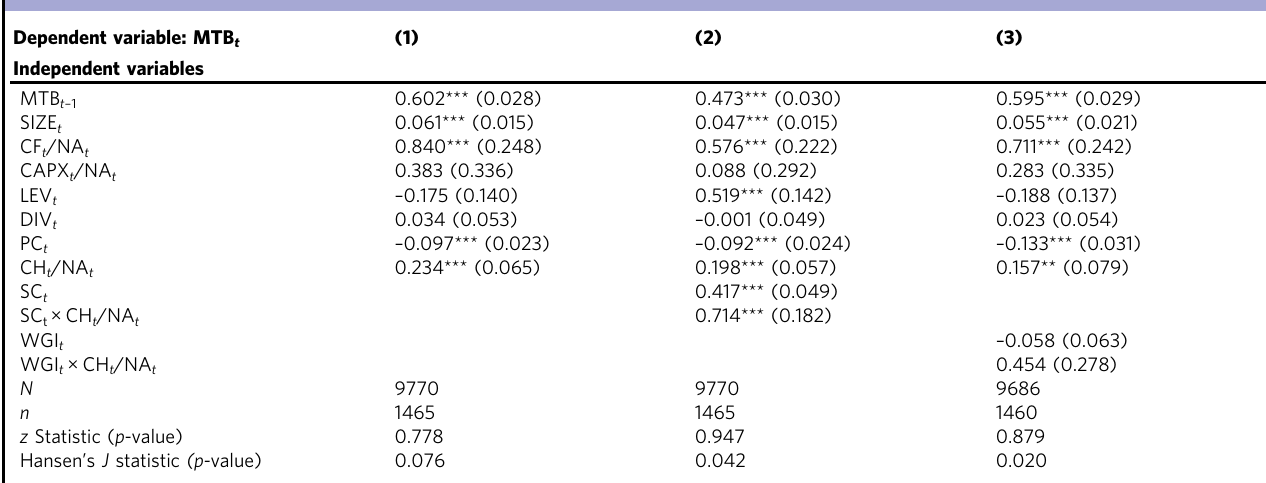
Table 4 Sharia compliance, national governance, and value of cash — full